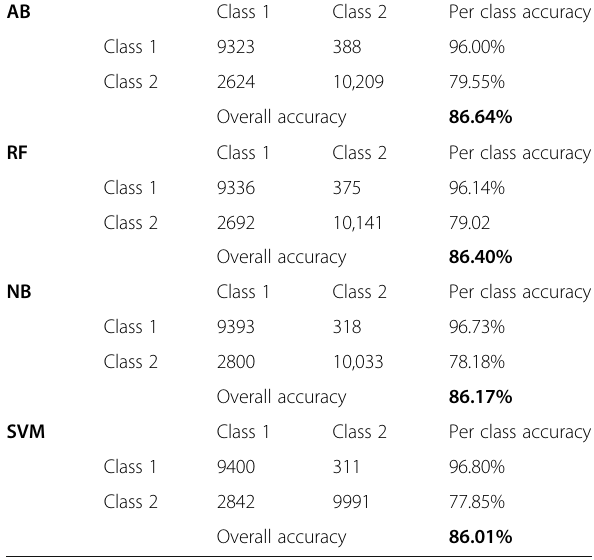
Table 2 Confusion matrixes of the best four performing ML models trained on the reduced feature space